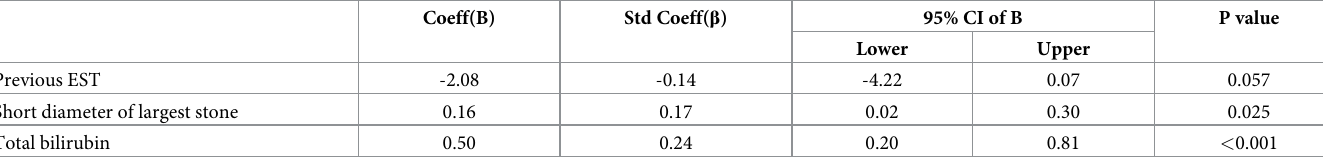
Table 4. Multivariate regression analysis of predictive factors for PTBD